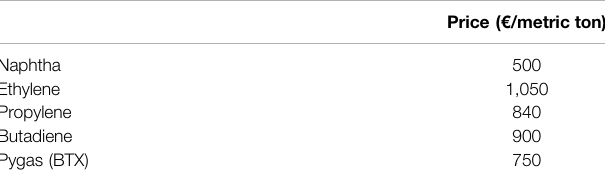
TABLE 2 | Applied pricing (March 2018) level for the major materials in this study (ICIS Pricing Database; Platts Global Ethylene Price Index; Platts Global Propylene Price